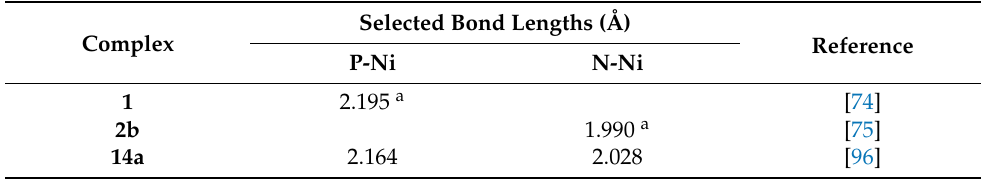
Table 1. Selected bond lengths (Å) of symmetrical nickel PCP and NCN pincer complexes 1 , 2b and unsymmetrical PCN complex 14a